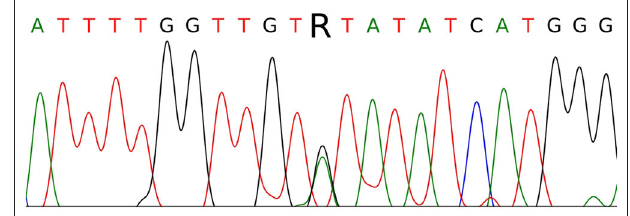
FIGURE 3 | Sanger sequencing of part of MET exon 16 in patient K. The c.3328G > A (p.V1110I) mutation is indicated by the letter